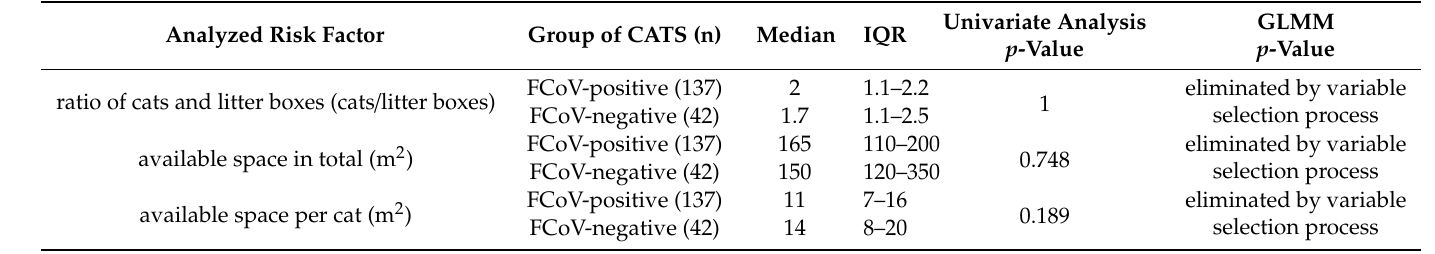
Table 5. Evaluated continuous risk factors and their influence on feline coronavirus (FCoV) shedding in univariate and multivariate analyses. Mann–Whitney U test was used for univariate analysis. A generalized linear mixed model (GLMM) was used for multivariate